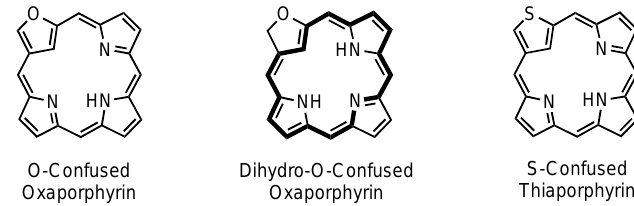
Figure 4. X-Confused Heteroporphyrins.